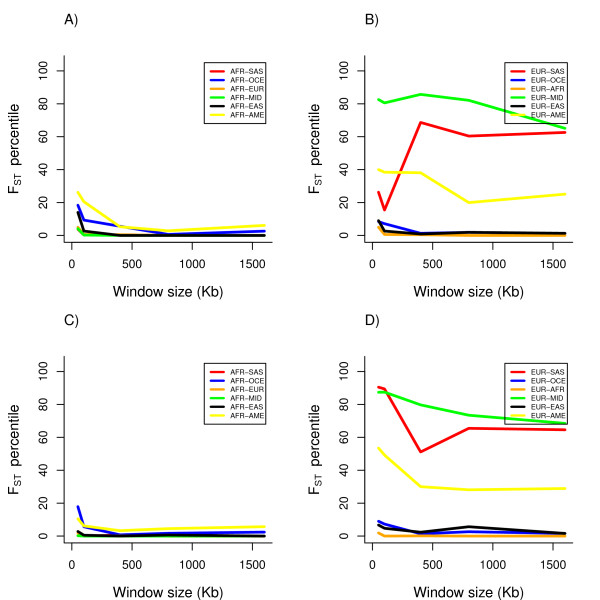
Pairwise FST percentile in relation to random regions on chromosome 6 at rs2395029 (HCP5) with expanding window size (50 Kb to 1600 Kb) for all AFR pairwise comparisons (panel A) and all EUR pairwise comparisons (panel B), and for rs9264942 (HLA-C) for all AFR pairwise comparisons (panel C) and all EUR pairwise comparisons (panel D). (AFR: sub-Saharan Africa; MID: Middle East; SAS: South Asia; EUR: Europe; EAS: East Asia; OCE: Oceania; AME: Americas)